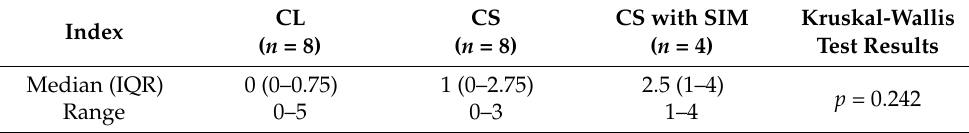
Table 2. Index summary between the experimental groups at 1 month.